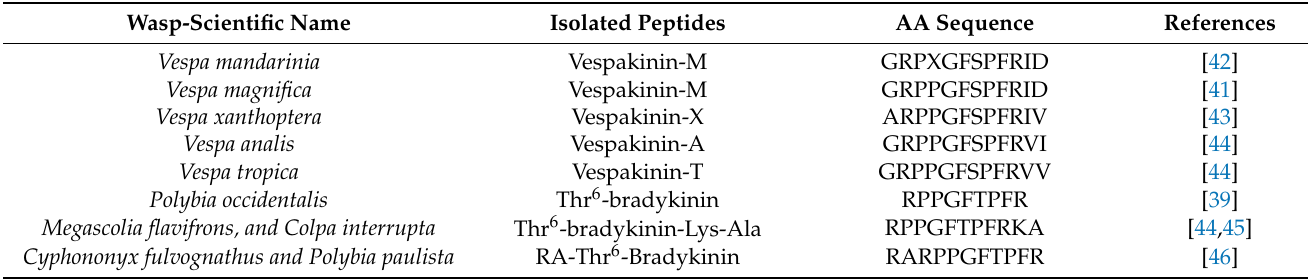
Table 2. Representative Kinins from WaspVenom.